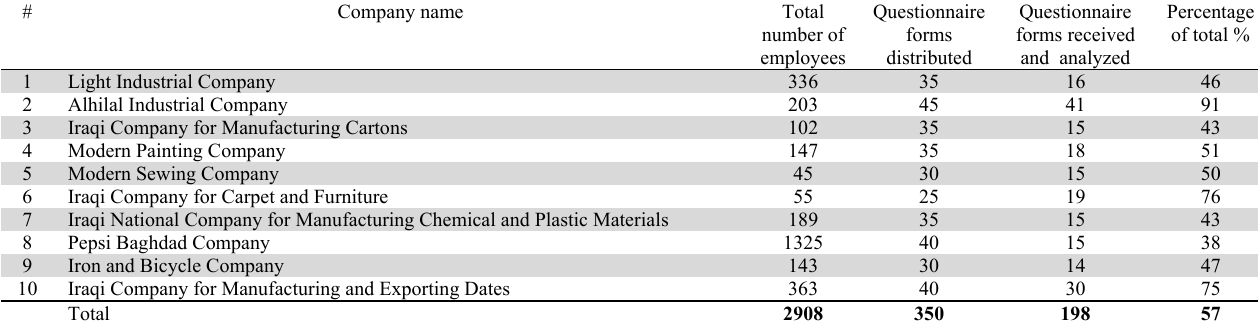
The summary of the questionnaire